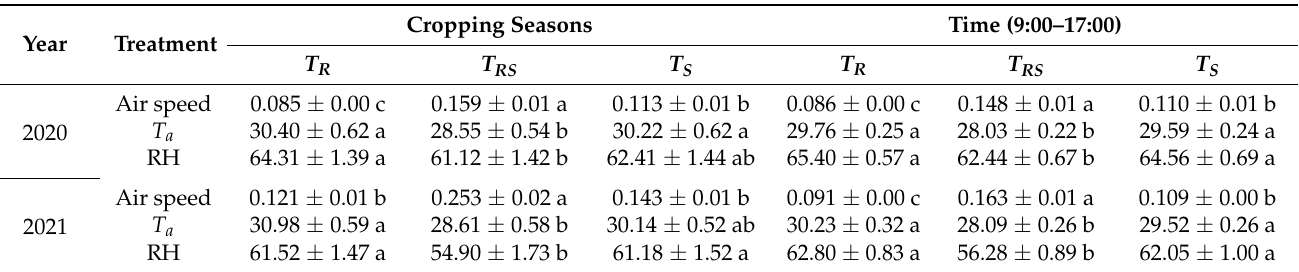
Table 1. Air speed (m s − 1 ), air temperature ( T a , ◦ C) and relative humidity (RH, %) inside the greenhouse under different ventilation treatments in 2020 and 2021.